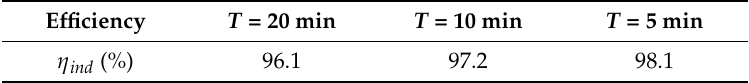
Table 10. Efficiency system for the second configuration varying the charging